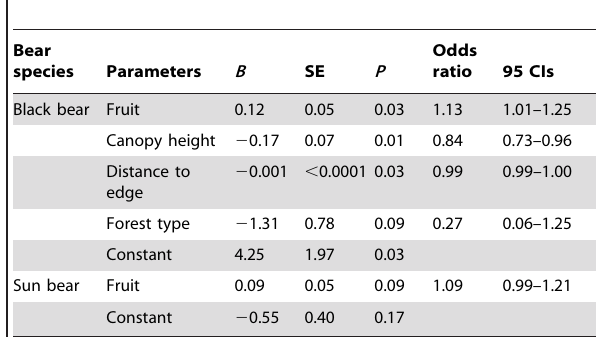
Table 4. Parameter estimates of best-fit models describing habitat selection by black bears and sun bears in Thung Yai Naresuan Wildlife Sanctuary, Thailand,